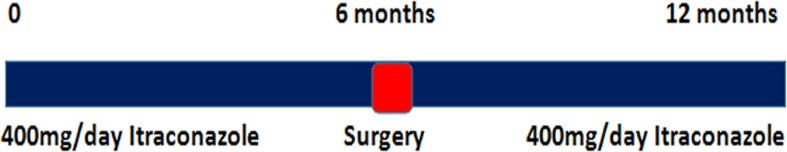
The mycetoma treatment protocol.